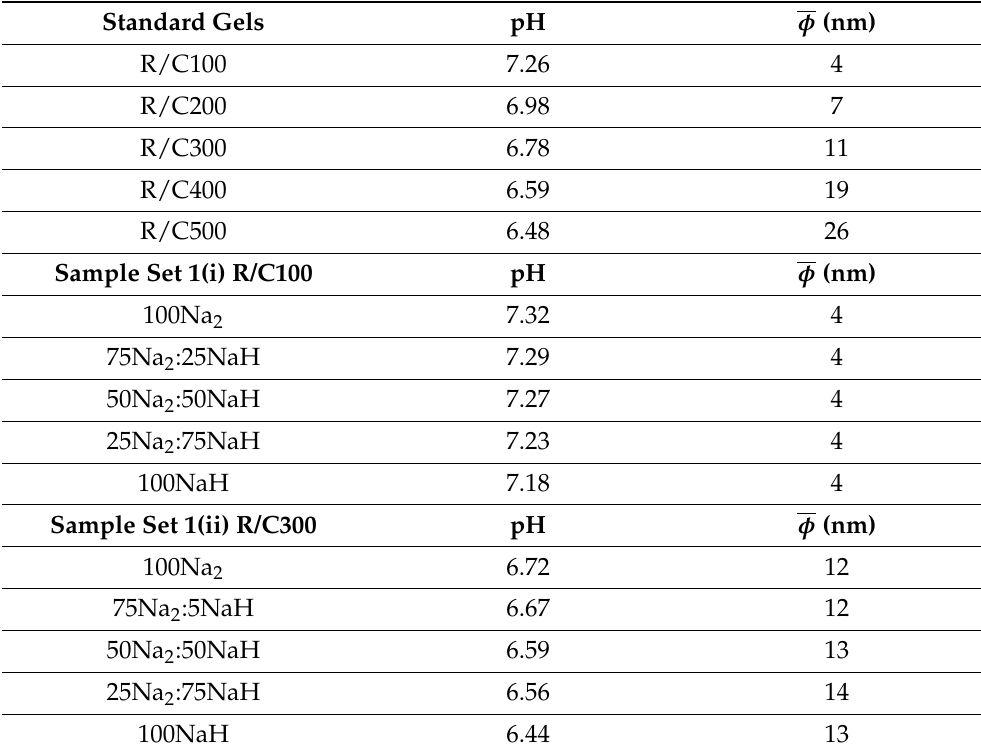
Table 2. Initial pH values of standard gels at varying resorcinol/catalyst molar ratios (R/C ratios), in addition to that of samples in sets 1(i) and 1(ii), and their corresponding average pore widths. The average pore width values are recorded to an accuracy less than their error, therefore their error values have been omitted. Note that φ is average pore